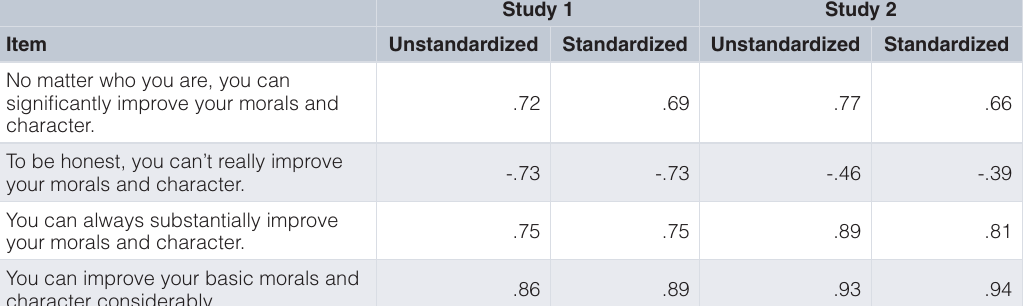
Table 2. Factor loadings from CFA in both